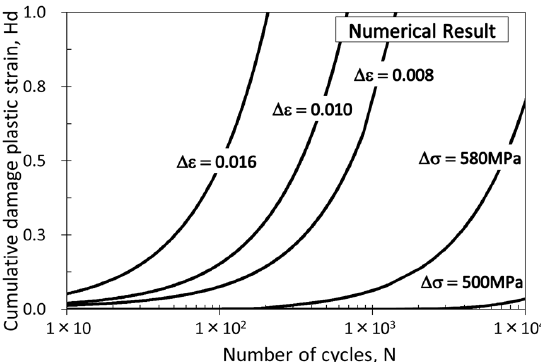
Figure 12. Relationship between cumulative damage plastic strain, H d , and number of cycles under constant amplitude loading.